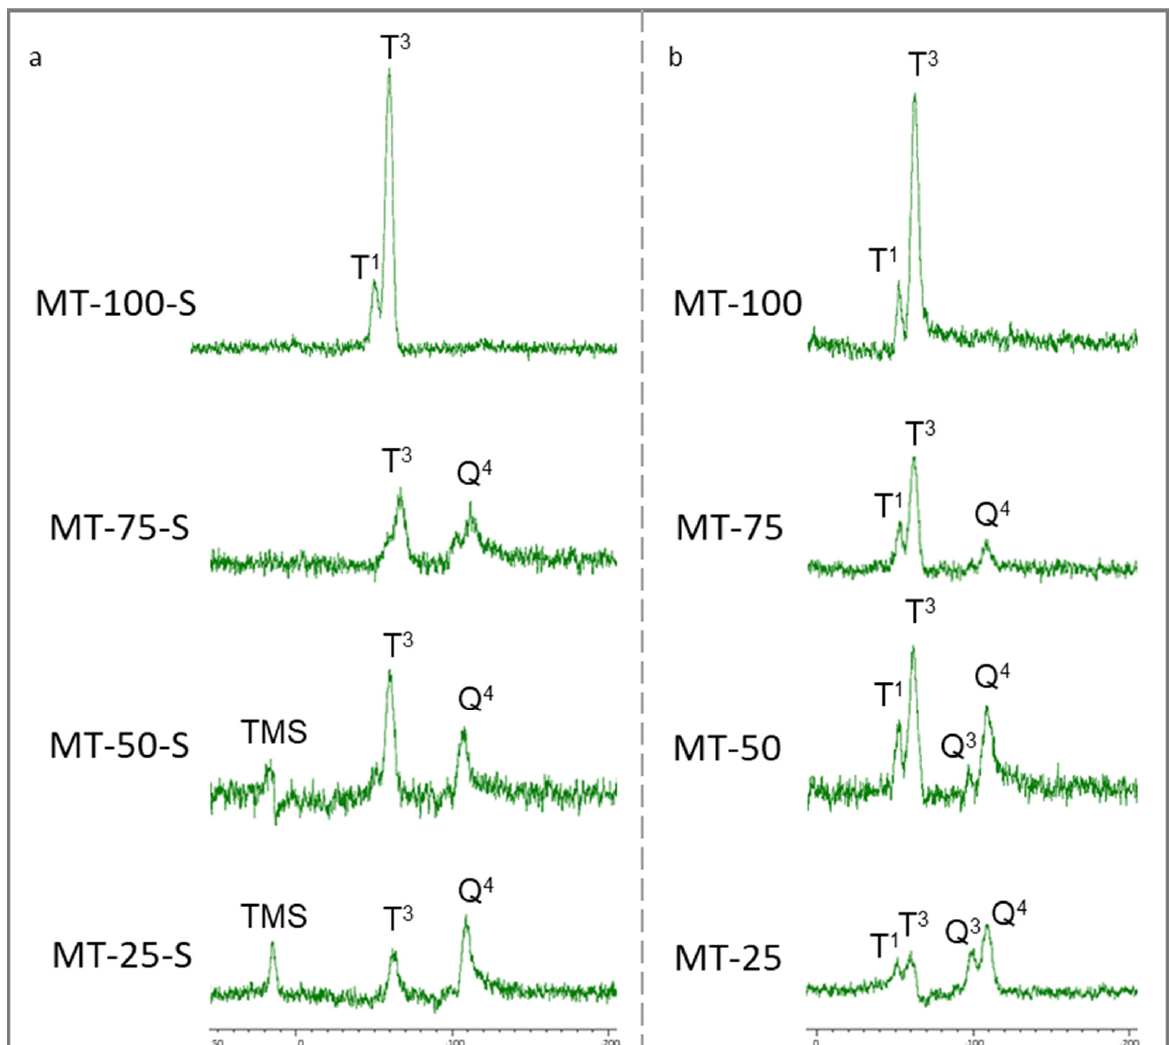
Figure 3. 29 Si MAS NMR spectra of the ( a ) silylated and ( b ) non ‐ silylated silica xerogels.